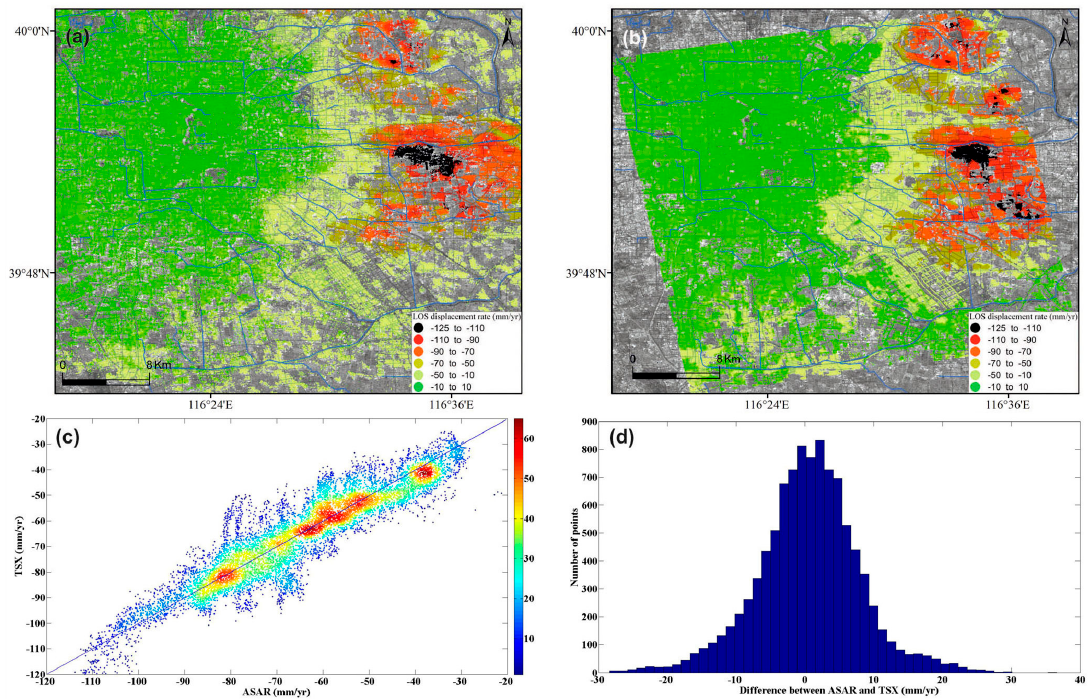
Figure 6. Displacement rates along LOS derived from ( a ) Envisat ASAR (2007~2010) and ( b ) TerraSAR-X (2010~2011) images. ( c ) Correlation and ( d ) differences analysis between Envisat ASAR and TerraSAR-X data.